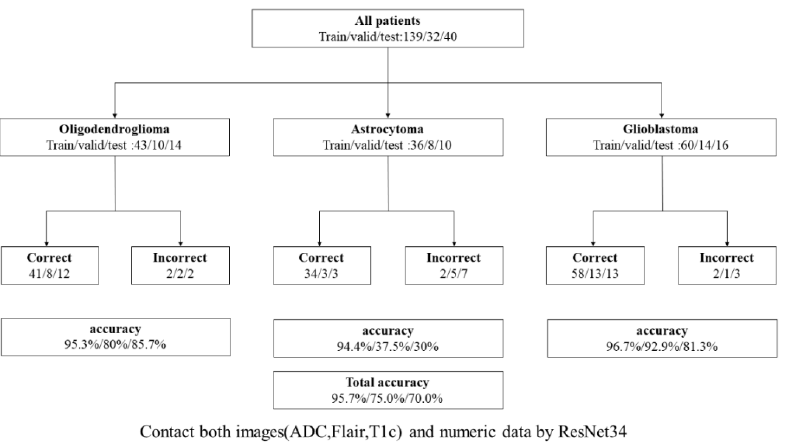
Figure 6. Patient accuracy and class accuracies of the final models. The 3-class model based on ResNet34, and integrated both image and numeric data, was selected as the best-performing model.